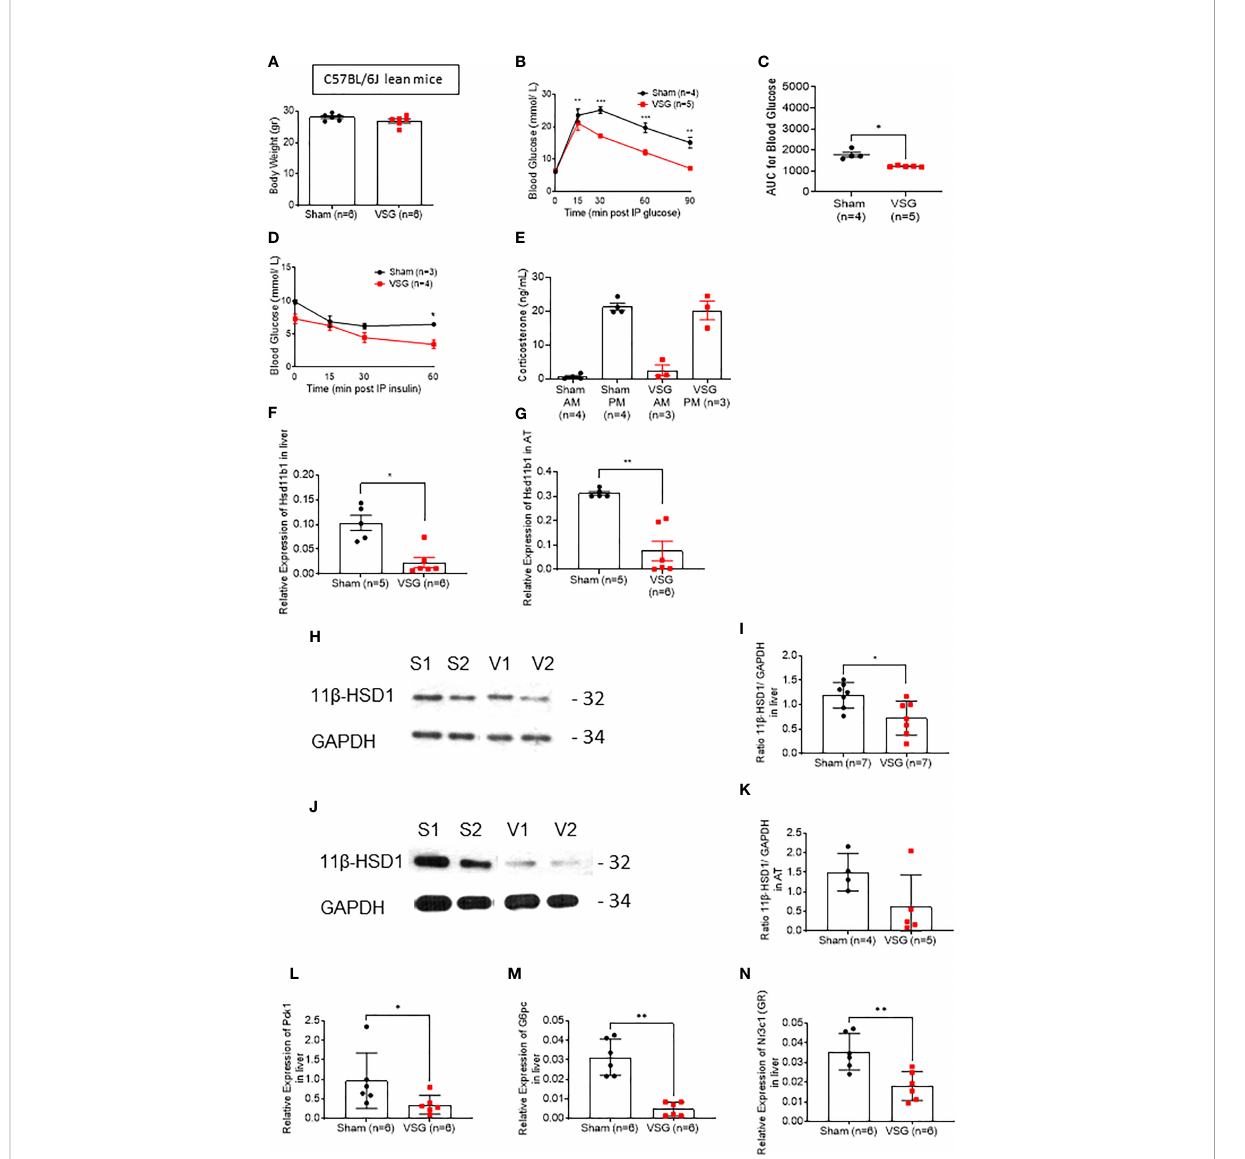
FIGURE 1 VSG improves glucose and insulin tolerance in lean mice. (A) Body weight at ten weeks following VSG (n = 6) or sham surgery (n = 6) in lean animals (B) IP glucose tolerance test in lean mice (3 g/kg) overnight fasting 4 weeks after surgery *P < 0.05, **P < 0.01, ***P < 0.001 Sham vs. VSG following 2-way ANOVA (C) Area under the Curve of (B) . *P < 0.05 Sham vs. VSG by two-sided unpaired Student ’ s t – test (D) Insulin tolerance test in lean mice (0.8 IU/kg) 6hr fasting, 4 weeks after surgery (E) Corticosterone measurement following blood collection at 0800 and 1900 within the same day, 4 weeks after surgery (F) Quantitative PCR levels of Hsd11b1 gene expression in liver *P < 0.05 Sham vs. VSG by two-sided unpaired Student ’ s t – test (G) Quantitative PCR levels of Hsd11b1 gene expression in subcutaneous adipose tissue **P < 0.01 Sham vs. VSG by two-sided unpaired Student ’ s t – test (H) Western Blot of liver lysate from sham and VSG mice for 11 b -HSD1 (32kDa) and GAPDH (34kDa) (I) Average intensity measurement from Western Blot immunoblotting quanti fi cation for 11 b -HSD1 and GAPDH in liver. *P < 0.05 Sham vs. VSG by two-sided unpaired Student ’ s t – test (J) Western Blot of adipose tissue lysate from sham and VSG mice for 11 b -HSD1 (32kDa) and GAPDH (34kDa) (K) Average intensity measurement from Western Blot immunoblotting quanti fi cation for 11 b -HSD1 and GAPDH in adipose tissue. *P < 0.05 Sham vs. VSG by two-sided unpaired Student ’ s t – test (L) Quantitative PCR levels of Pck1 gene expression in liver *P < 0.05 Sham vs. VSG by two-sided unpaired Student ’ s t – test (M) Quantitative PCR levels of G6pc gene expression in liver *P < 0.01 Sham vs. VSG by two-sided unpaired Student ’ s t – test. (N) Quantitative PCR levels of Nr3c1 (GR) gene expression in liver **P < 0.01 Sham vs. VSG by two-sided unpaired Student ’ s t – test. Data are expressed as means ±